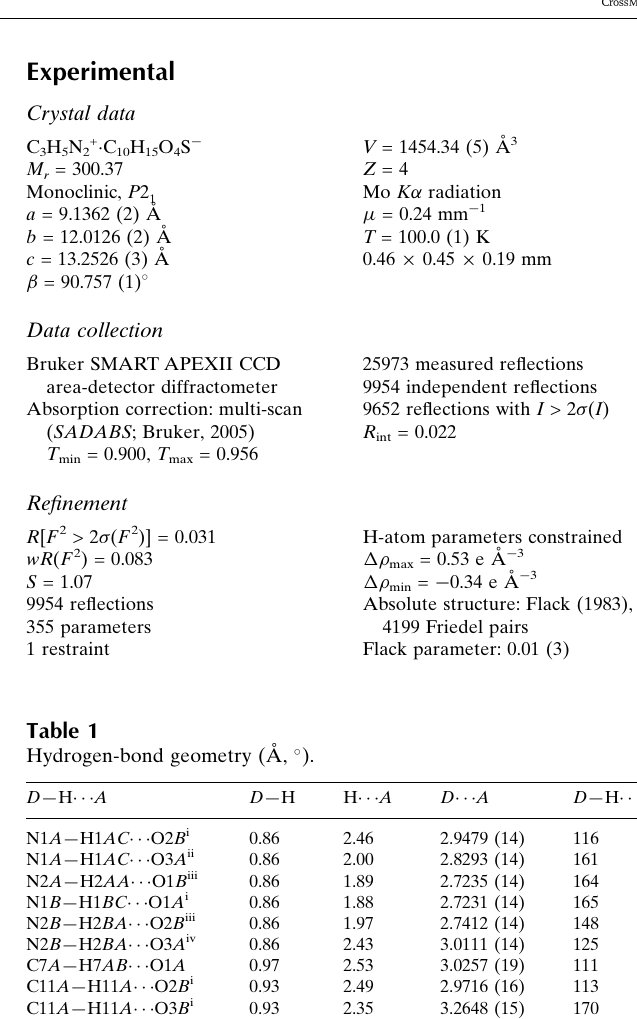
structure which link the molecules into a two-dimensional network parallel to the (100) plane.